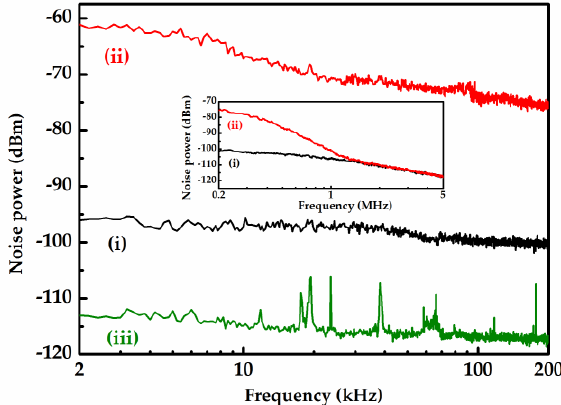
Figure 4. Intensity noise of the LO as a function of analysis frequencies: Curve (i), the SNL; Curve (ii), the intensity noise of the LO; and Curve (iii), the ENL. The inset is the intensity noise of the LO at analysis frequencies from 0.2 MHz to 5 MHz.